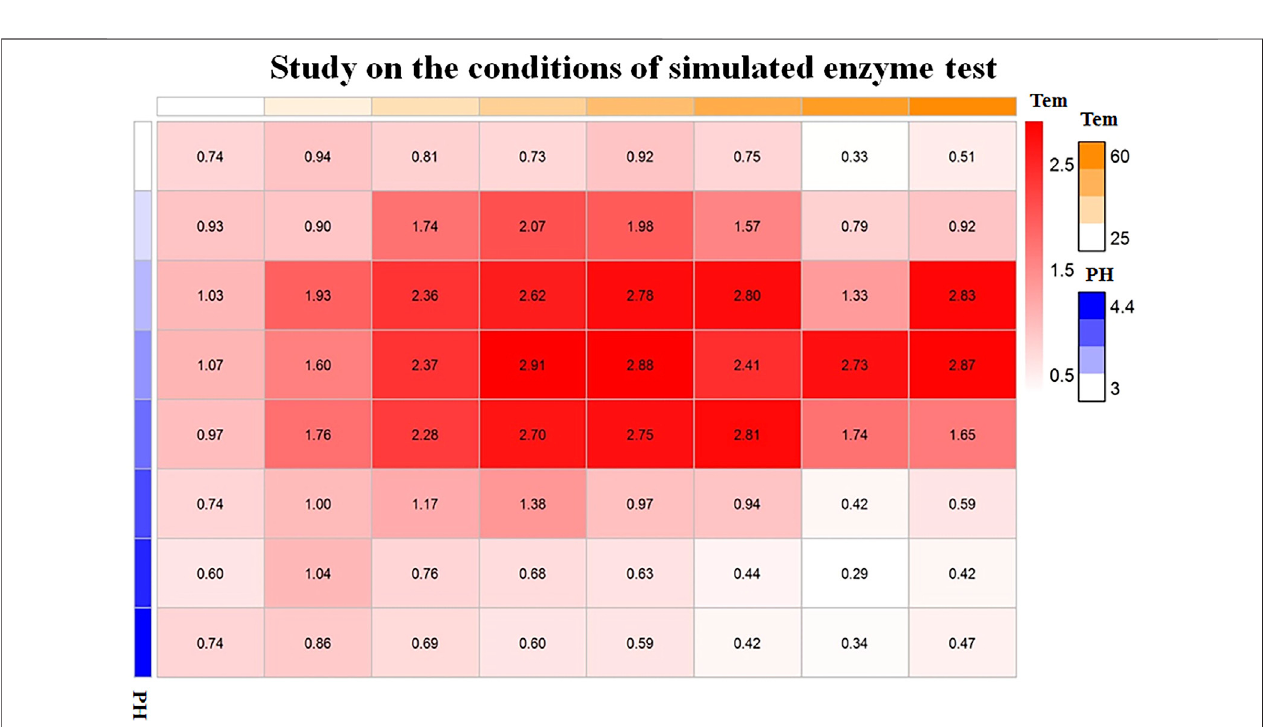
Frontiers in Chemistry |